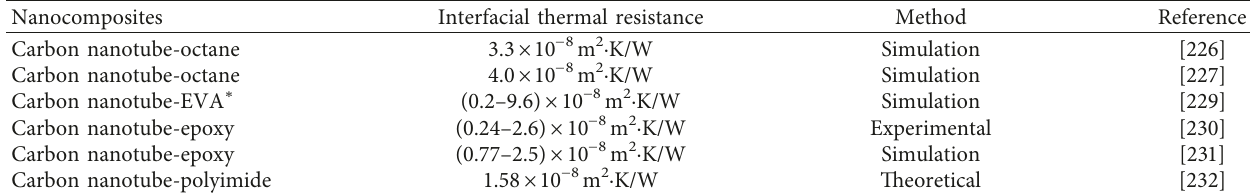
Table 2: Thermal resistance of the interface in carbon nanotube-reinforced polymer nanocomposites.